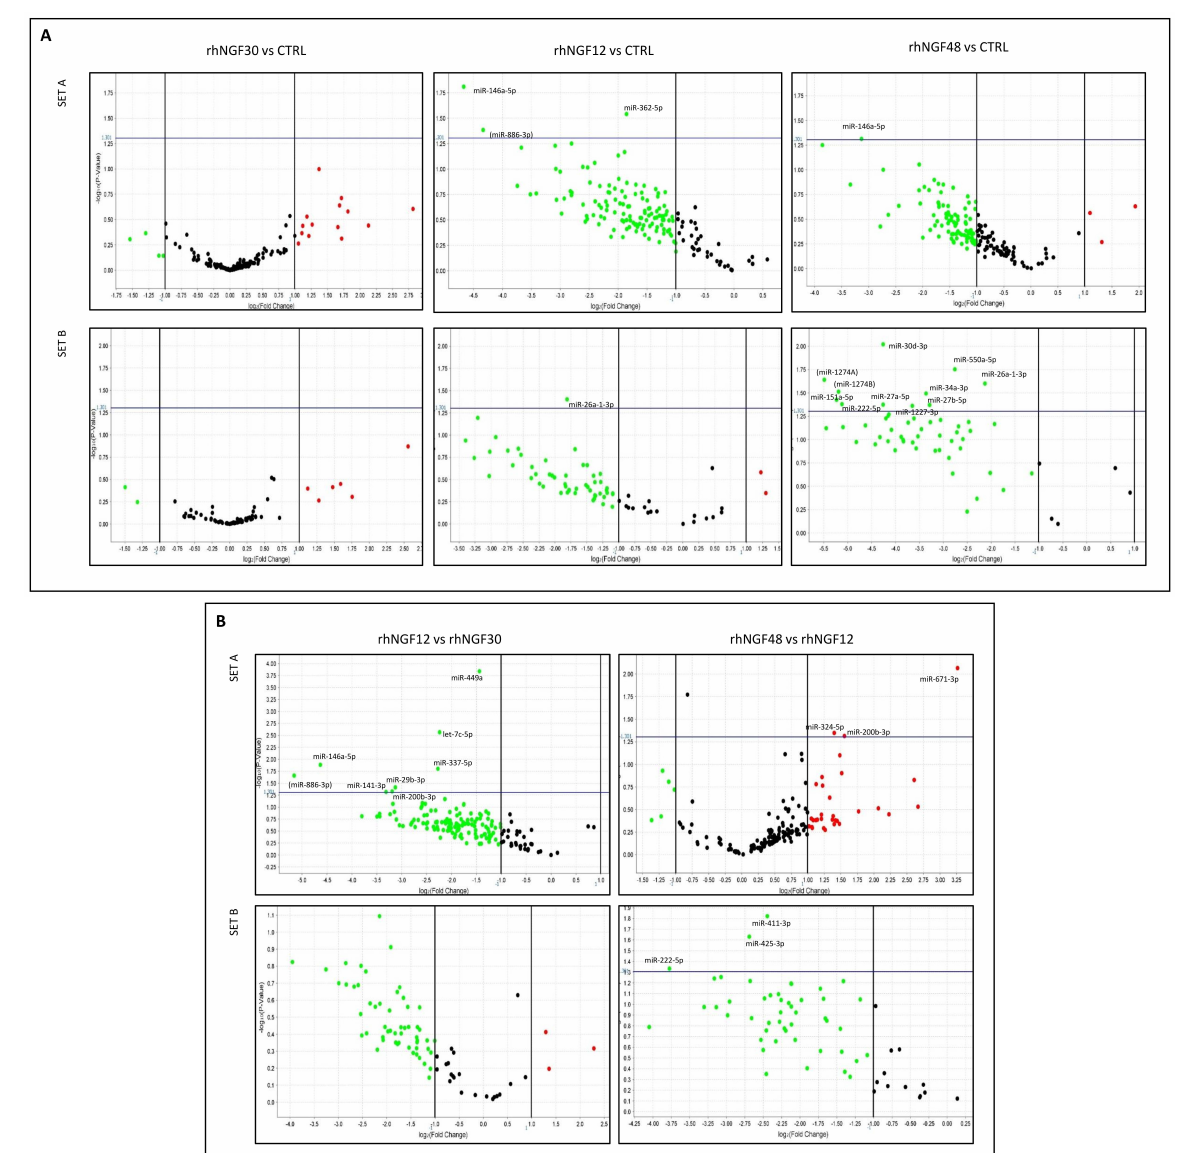
Figure 1. MiRNA expression in HCEpiCs in response to rhNGF. Volcano plots from human mi- croRNA array cards Set ( A ) (top) and Set ( B ) (bottom) analysis, representing levels of miRNAs with respect to unstimulated cells (CTRL) ( A ) and, dynamically, through experimental time points ( B ). Significant miRNAs IDs are reported close to the corresponding plot. x axis: fold change (RQ, relative quantification, log scale); y axis: p -value (log scale). Horizontal blue line: p = 0.05 threshold. Between brackets: miRs not currently listed in the MiRbase